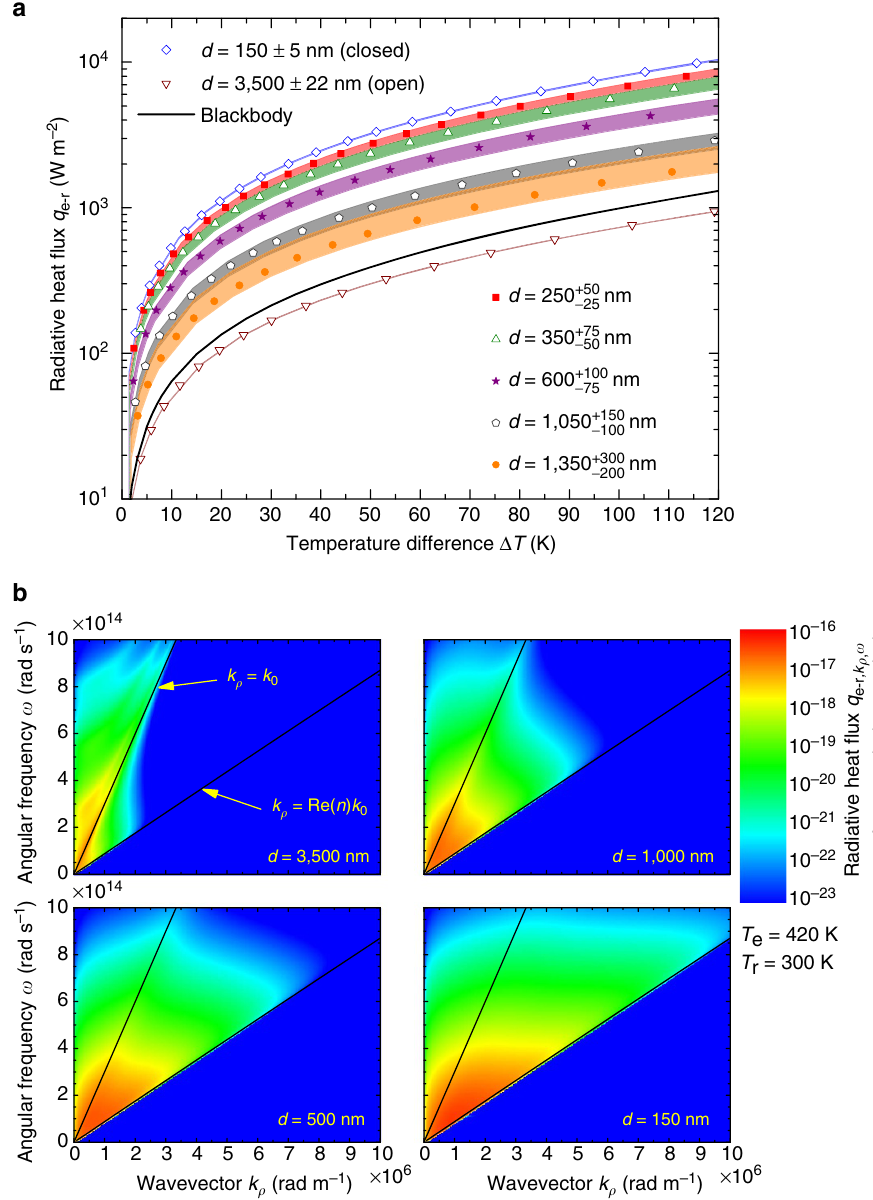
Figure 3 | Gap- and temperature-dependent radiative heat flux between the emitter and receiver. ( a ) The symbols show the experimental heat flux between the 5 (cid:2) 5mm 2 emitter and receiver, q e–r , where the background heat transfer has been subtracted. The coloured bands are fluctuational electrodynamics predictions. In the closed position ( d ¼ 150nm) and for a temperature difference D T of 115.6K, the experimental radiative heat flux exceeds the blackbody predictions by a factor of 8.4. In the open position ( d ¼ 3,500nm), the measured radiative heat flux is below the blackbody predictions due to a modest contribution from evanescent modes. ( b ) Calculated dispersion relations showing the radiative heat flux, q e–r, k and angular frequency o for gaps of 3,500, 1,000, 500 and 150nm, and emitter ( T e ) and receiver ( T r ) temperatures of 420 and 300K, respectively. The region where k r is smaller than the magnitude of the wavevector in vacuum, k 0 , corresponds to modes that are propagating in the vacuum gap. The zone defined by k 0 o k r o Re( n ) k 0 , where n is the refractive index of silicon (Si), describes frustrated modes that are propagating in Si but evanescent in the vacuum gap. Radiation enhancement in the near field for the case of intrinsic Si is solely due to these frustrated modes that have an increasing contribution to heat transfer as the separation gap d In summary, using a custom-fabricated device made of two 5 (cid:2) 5 mm 2 intrinsic Si surfaces separated by a tunable vacuum gap, we measured a maximum radiation transfer enhancement over the blackbody limit by a factor of 8.4 for a 150-nm-thick gap and a temperature difference of 115.6 K while minimizing heat conduction. Our near-field radiative heat transfer device, capable of delivering considerable radiation heat rates because of the